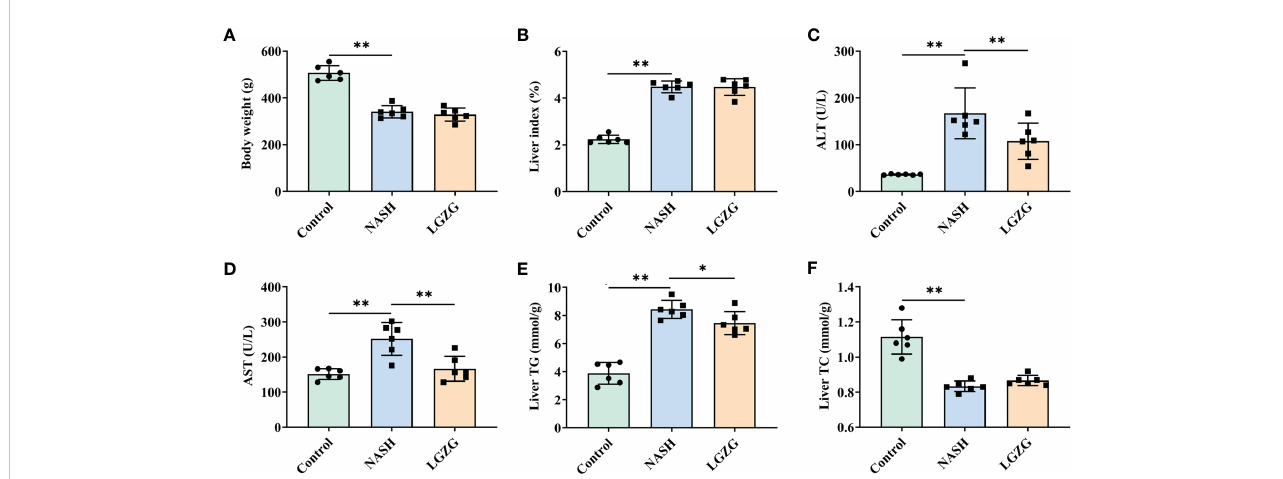
FIGURE 1 LGZG improved serum AST, ALT and liver TG in NASH. (A) Body weight (g), (B) Liver index, the ratio of liver weight to body weight (%). Livers were isolated and washed with normal saline at the end of the experiment. Livers were weighed and the liver index was calculated. (C) Serum AST (U/L), (D) Serum ALT level (U/L), (E) . Liver TG level (mmol/g), and (F) . Liver TC level (mmol/g). Serum ALT, AST and liver TG, TC levels were measured using an automatic biochemical analyzer. The green bar represents the Control group, the blue bar represents the NASH group, and the yellow bar represents the LGZG group (n=6 per group). Data are expressed as the mean±SD (*p < 0.05; **p < 0.01).